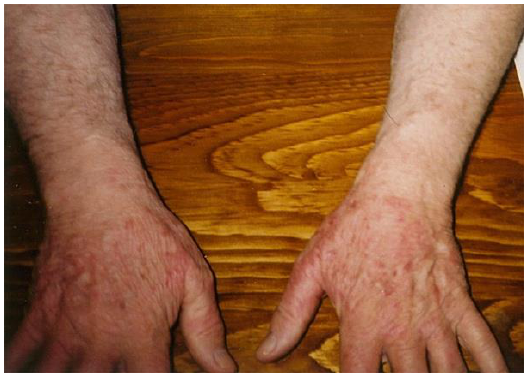
Figure 3. Rash on hands with reddish-blue discoloration is consistent with ACA. The discoloration resolved temporarily with antibiotic treatment, and then recrudesced. With antibiotic treatment this patient was able to function in society with reduced